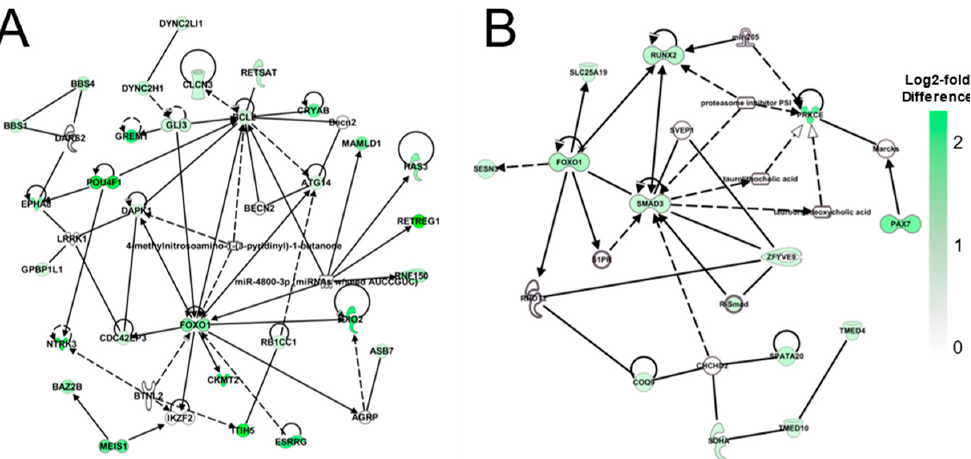
Figure 4. The network visualization of pathway analysis for modules 7 ( A ) and 10 ( B ) from fusion positive network analysis. All genes were upregulated in PAX7 samples compared to PAX3 ; however, the degree to which genes were upregulated varied. Genes with green coloration had higher log 2 -fold change. Solid lines indicate a direct relationship between two genes, whereas dashed lines indicate an indirect predicted relationship. FOXO1 and PAX7 were important genes for both modules and showed 2-fold and 3-fold increase respectively in PAX7 samples.